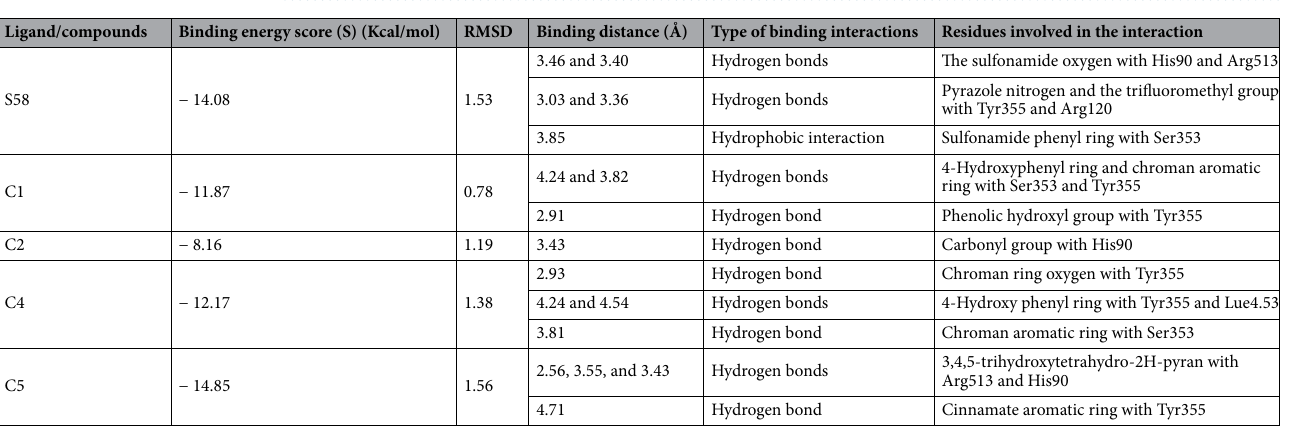
Table 2. The molecular docking